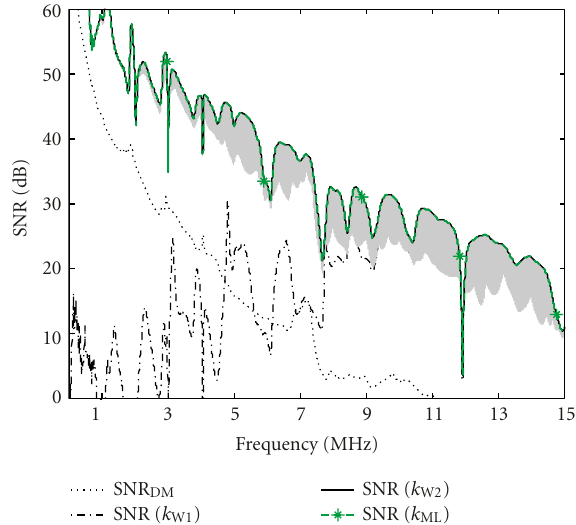
Figure 8: SNRs for near-far scenario. The improvement in terms of SNR for subchannels above 1MHz is significant. For frequencies above 7 MHz, adaptive interference cancellation yields SNR values that make transmission on these subchannel sensible, which would not be possible by processing the DM signal only. The grey-shaded area indicates SNR values for coe ffi cient mismatch of up to 10% (SNR( K 0 . 1